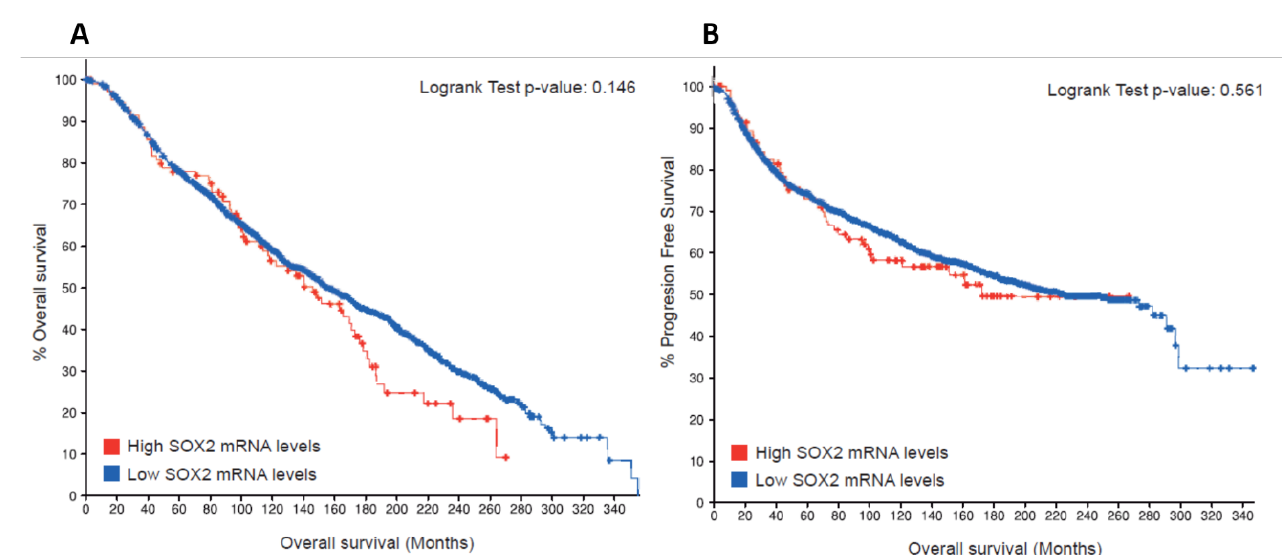
Figure 1. Kaplan-Meier estimated overall survival ( A ) and progression-free survival ( B ) in patients ( n = 1904) affected by breast cancer from cBioPortal. Patients with low SOX2 mRNA levels ( n = 106) showed an increased survival rate compared to high SOX2 expressing patients ( n = 1798).